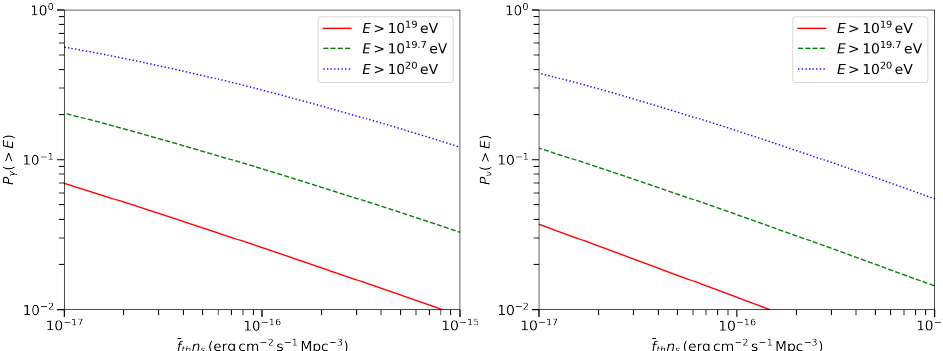
Figure 2. Average detection probability for gamma-ray/neutrino sources toward UHECR directions as a function of the product of source number density and the gamma-ray/neutrino telescope sensitivity. Left panel: observation of >2 TeV gamma-rays. Right panel: observation of >100 TeV neutrinos. The three lines correspond to three lower limits of cosmic ray energy, E > 10 19 eV, E > 10 19.7 eV and E > 10 20